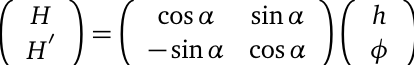
Figure 2: Expected 95% C.L. cross section limits for new scalar H